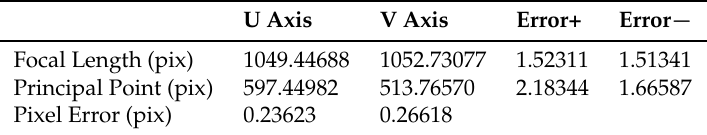
Table 2. Intrinsic parameters of the left camera.